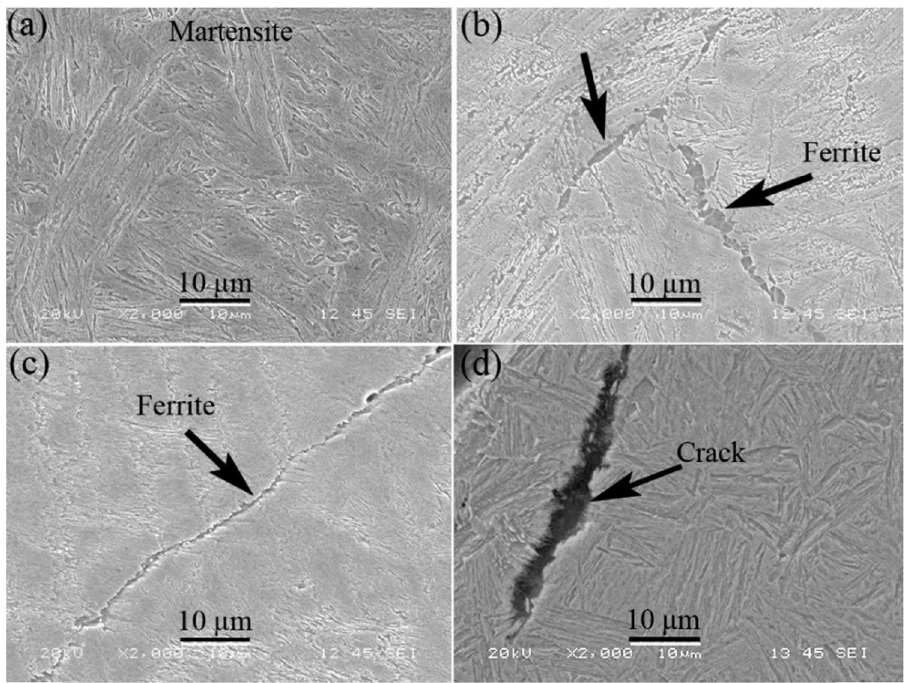
Figure 7: Microstructures near fracture surface at 750°C with a strain rate of 0.005 s − 1 observed by SEM: ( a ) steel 1#; ( b ) steel 2#; ( c ) steel 3#; ( d ) steel